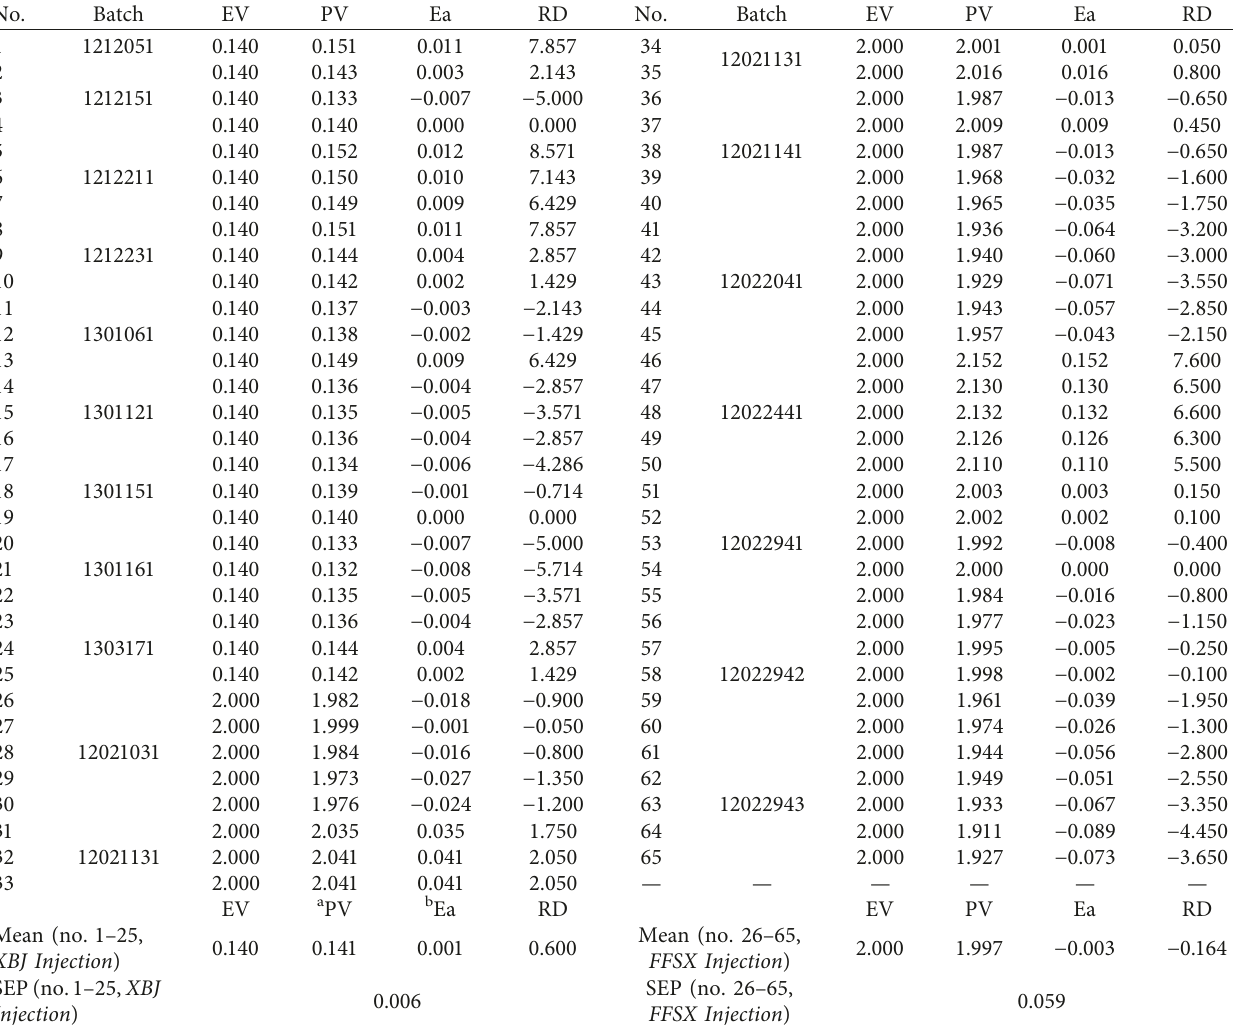
Table 2: Experimental vs. predictive values of Tween-80 in XBJ Injection and FFSX Injection